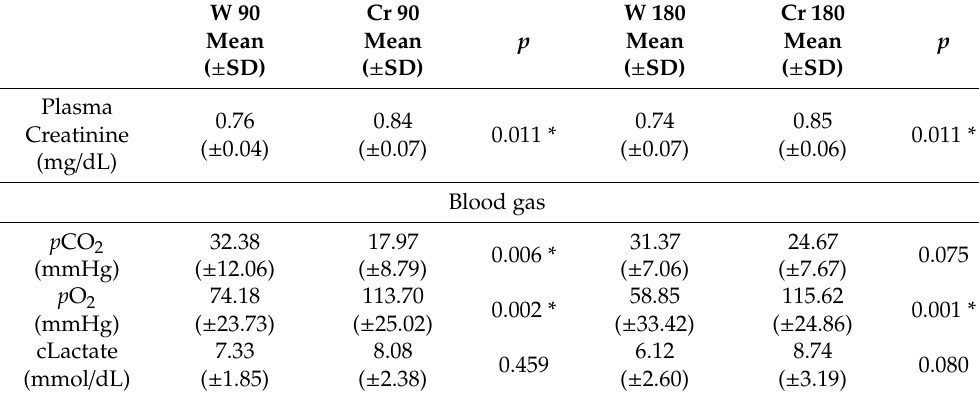
Table 3. Creatinine and blood gases concentration.